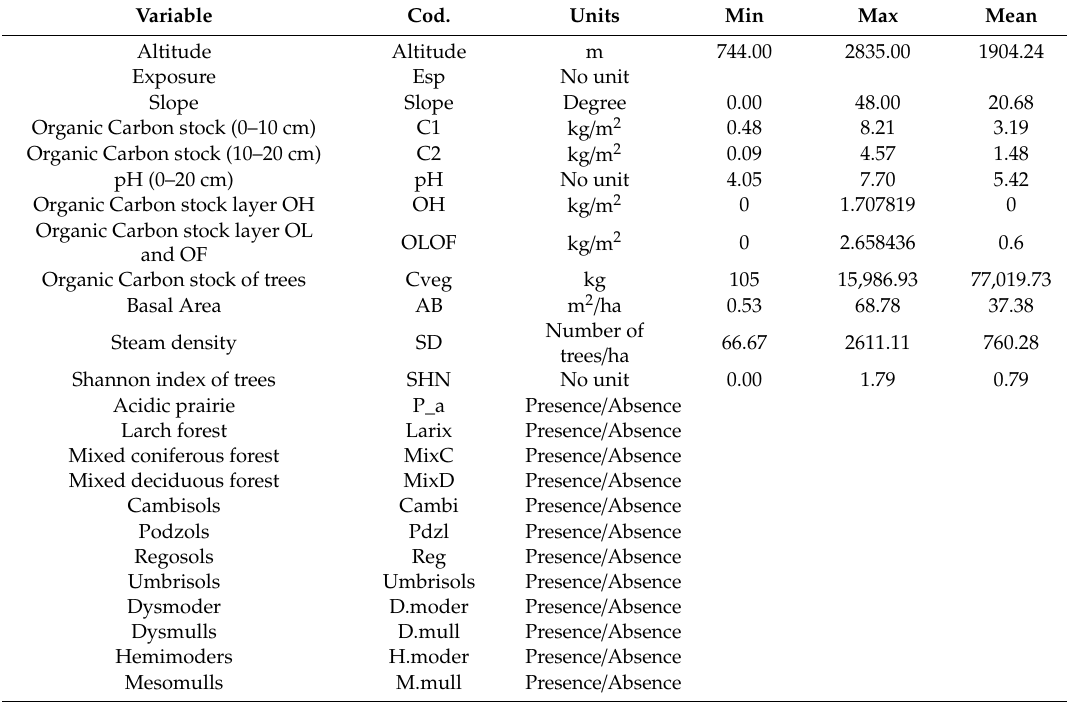
Table 4. Environmental features used in canonical correlation analysis (CCA) analysis.